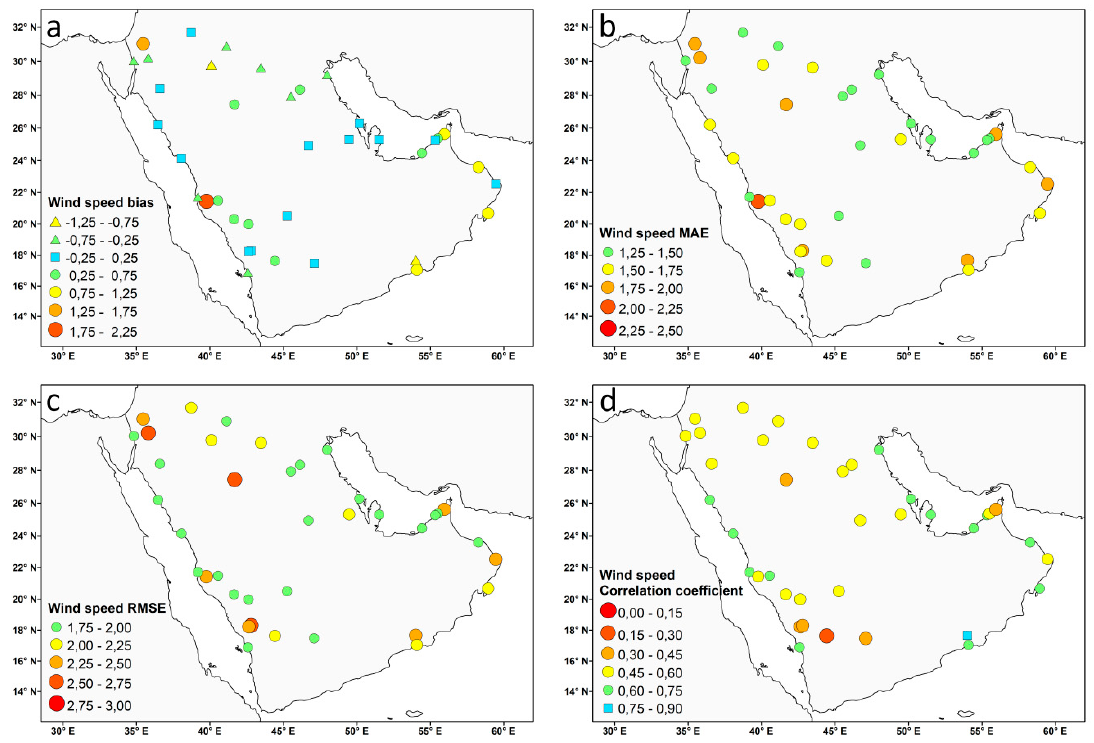
Figure 2. Wind speed evaluation map for ( a ) Mean Bias Error (MBE), ( b ) Mean Absolute Error (MAE), ( c ) Root Mean Square Error (RMSE), and ( d ) the Correlation Coefficient.